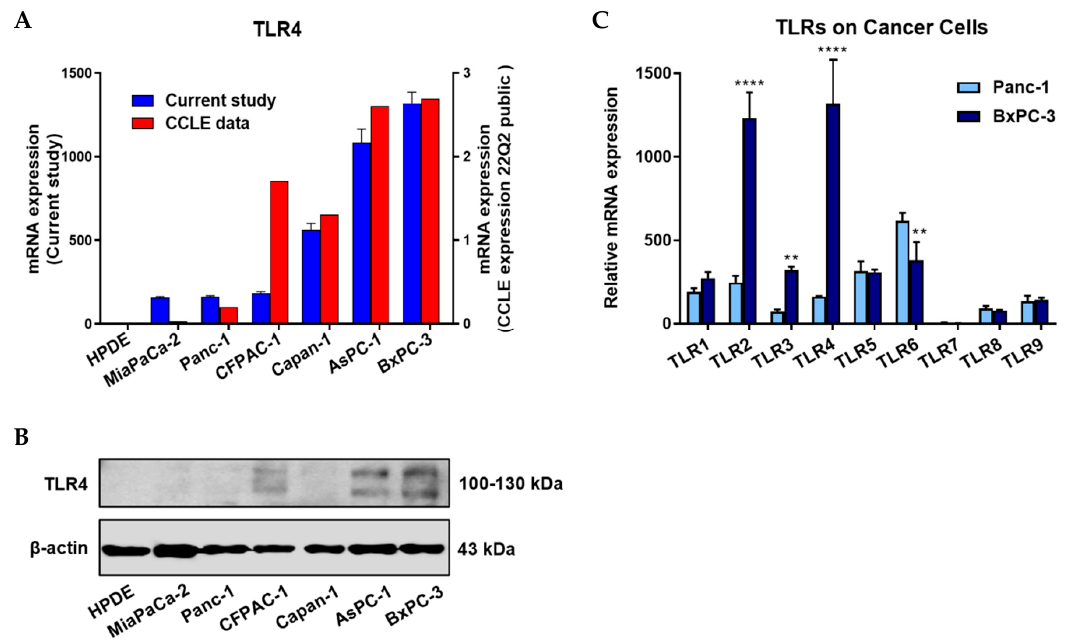
Figure 1. Positive TLR4 expression is detected in six different pancreatic cancer cell lines but not the HPDE normal pancreatic cell line. ( A ) mRNA expression levels of TLR4 quantified by RT-qPCR from the current study and retrieved from the Cancer Cell Line Encyclopedia (CCLE) Expression 22Q2 Public database. ( B ) Protein expression level of TLR4 assessed by Western blot analyses, the two bands of TLR4 appeared to be glycosylated (130 kDa) and deglycosulated (100 kDa) TLR4 [ 9 , 10 ] . ( C ) Relative mRNA levels of TLR1~9 in two representative pancreatic cancer cell lines. The mRNA expression levels were adjusted based on the two cell lines’ TLR4 data from ( A ). Data are represented as a mean ± SD from triplicates, ** p < 0.01, **** p < 0.0001 (indicating differences between Panc-1 and BxPC-3) were obtained from two-way ANOVA and post-hoc multiple comparisons with Bonferroni correction. 2.2. Endogenous Ligands Induced PC Cell Migration via TLR4 Using TAK-242, a chemical TLR4 inhibitor, we showed that PC cell-secreted ligands induced PC migration via TLR4 by transwell assay. BxPC-3 and Panc-1 cells were seeded in the upper chambers containing TAK-242 (at 1, 2, and 4 µM), and incubated for 24 h. As shown in Figure 2A, TAK-242 reduced the migration of BxPC-3 cells in a dose-dependent manner (Jonckheere-Terpstra test, p < 0.001). By contrast, the migration of Panc-1 cells was not changed by TAK-242. To confirm whether the reduction of migratory ability was owed to the cytotoxicity of TAK-242, we performed WST-1 assays. Cell viability was not changed after BxPC-3 and Panc-1 cells were treated by TAK-242 (at 1, 2, or 4 µM) for 24 h (Figure 2B).